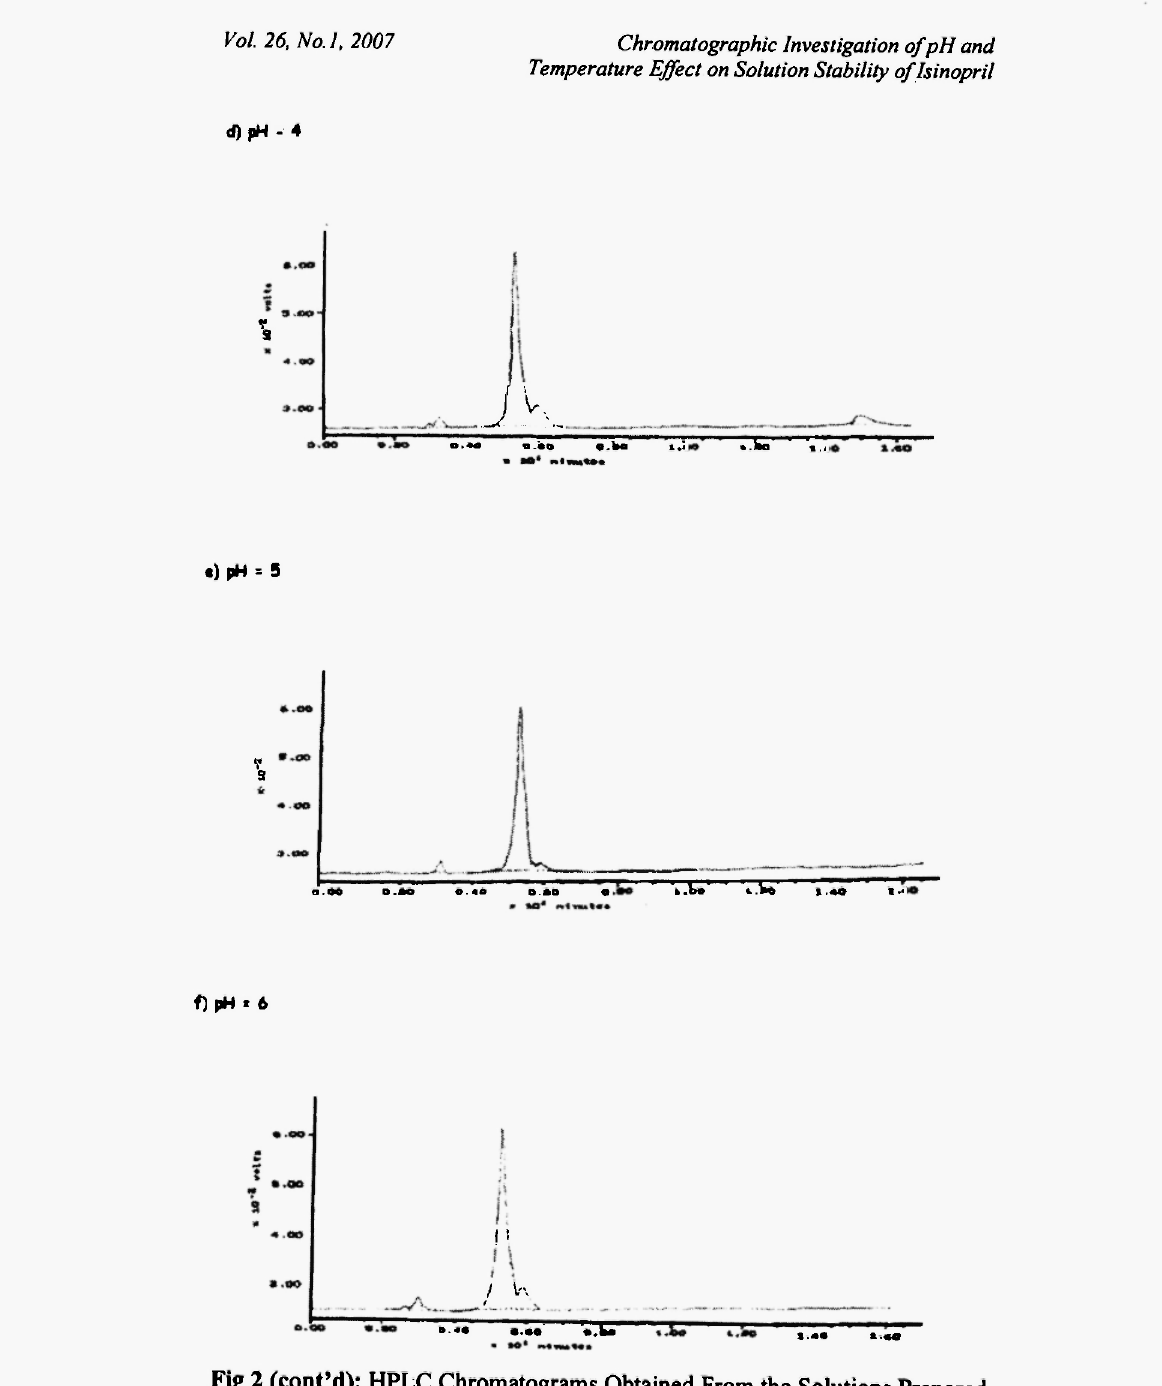
Fig 2 (cont'd): HPLC Chromatograms Obtained From the Solutions Prepared at Various pH's and Kept at 80°C for 120h